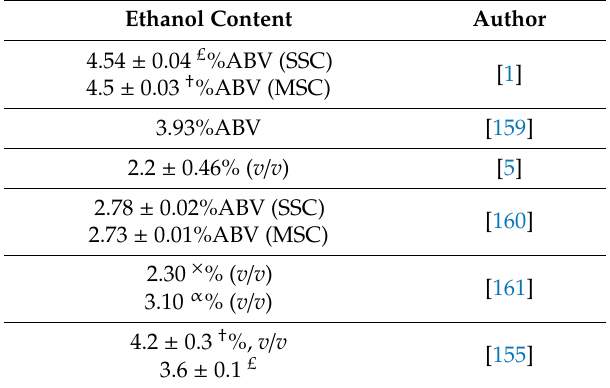
Table 6. Alcohol concentration of various pito obtained from the